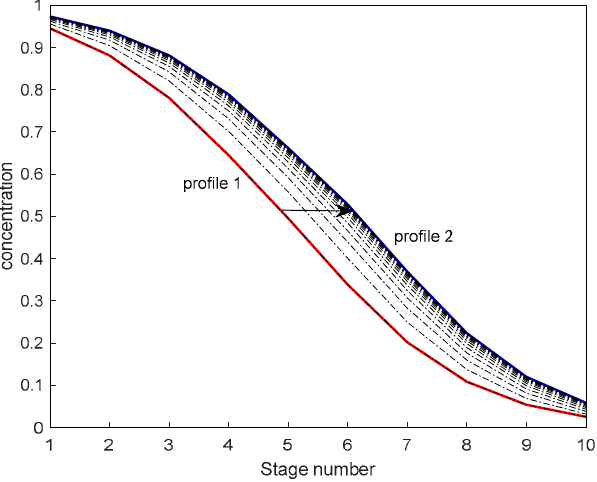
Figure 2. The movement of concentration distribution curve when Z f +5%. Essentially, the motion of the concentration distribution curve is a symptom of the mass transfer in the separation process. Figure 3 is a schematic diagram of the balanced relationship of a single tray. A basic assumption is adopted in the tray model that the